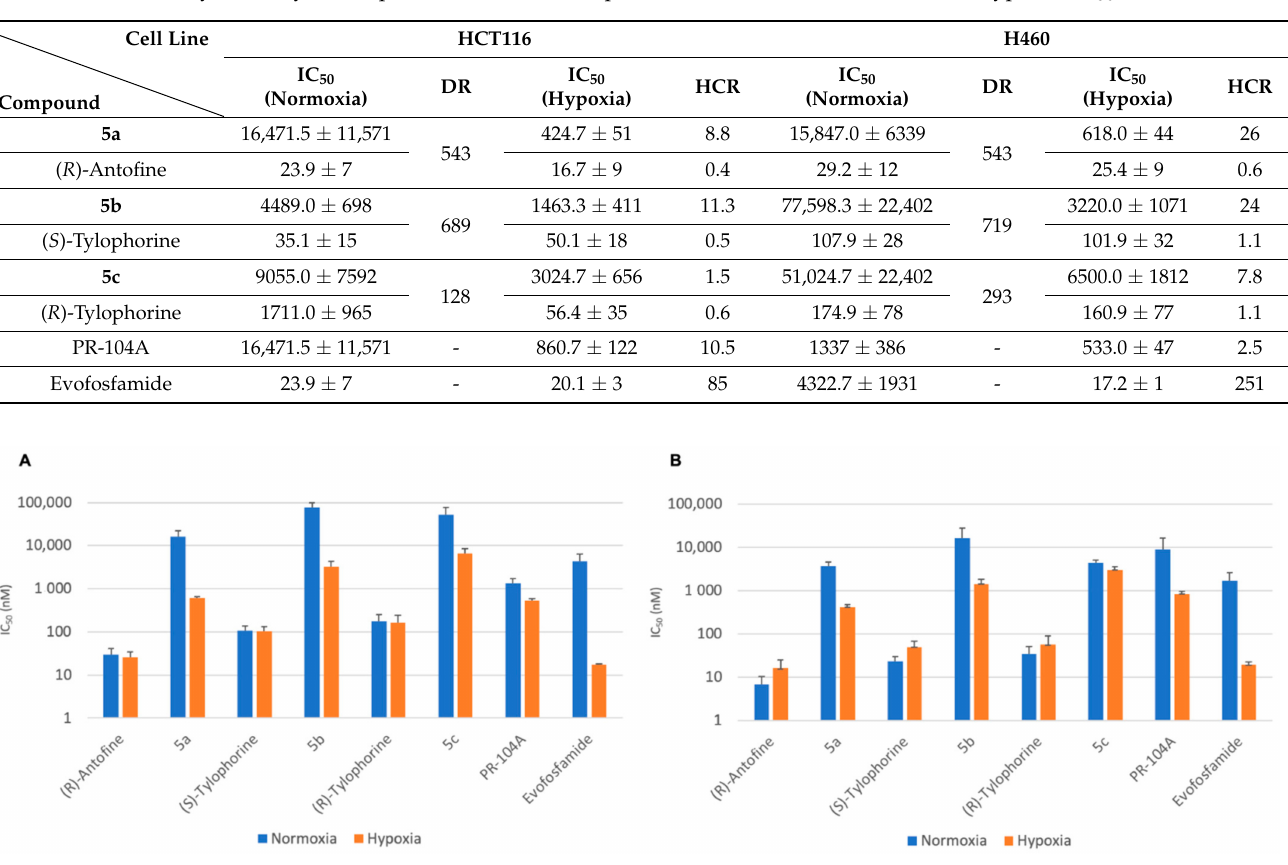
(Table 5). The prodrugs were much less cytotoxic than the parent drugs, in agreement with our observations using the other cell lines described above (Figure 6). Table 5. Cytotoxicity of compounds 5a – c and their parent alkaloids under normoxia and hypoxia (IC 50 , nM).